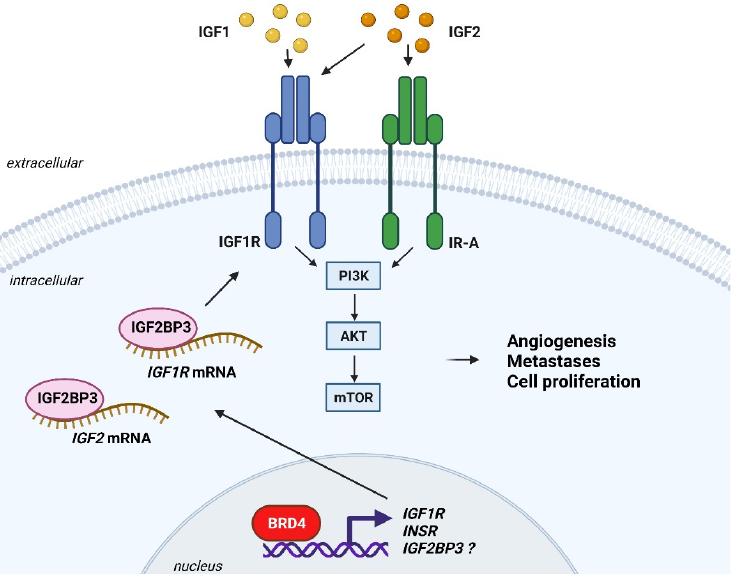
Figure 3. Schematic representation of the functional cross-talk between the IGF system and the BET proteins in cancer. In the nucleus, BRD4 binds the transcriptional start site of the IGF1R and INSR and modulates their expression. Whether BRD4 might directly regulate IGF2BP3 mRNA expression has to be established. In the cytoplasm, IGF2BP3 sustains IGF2 and IGF1R translation. Ligand binding to the IGF1R or IR-A activates the PI3K/Akt/mTOR. Biological responses evoked by the IGF/BET proteins in cancer are reported.